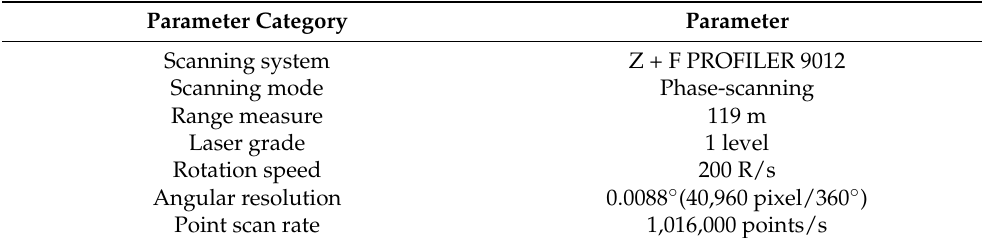
Table 1. Technical parameters of German Z + F 3D laser scanner PROFILER 9012.